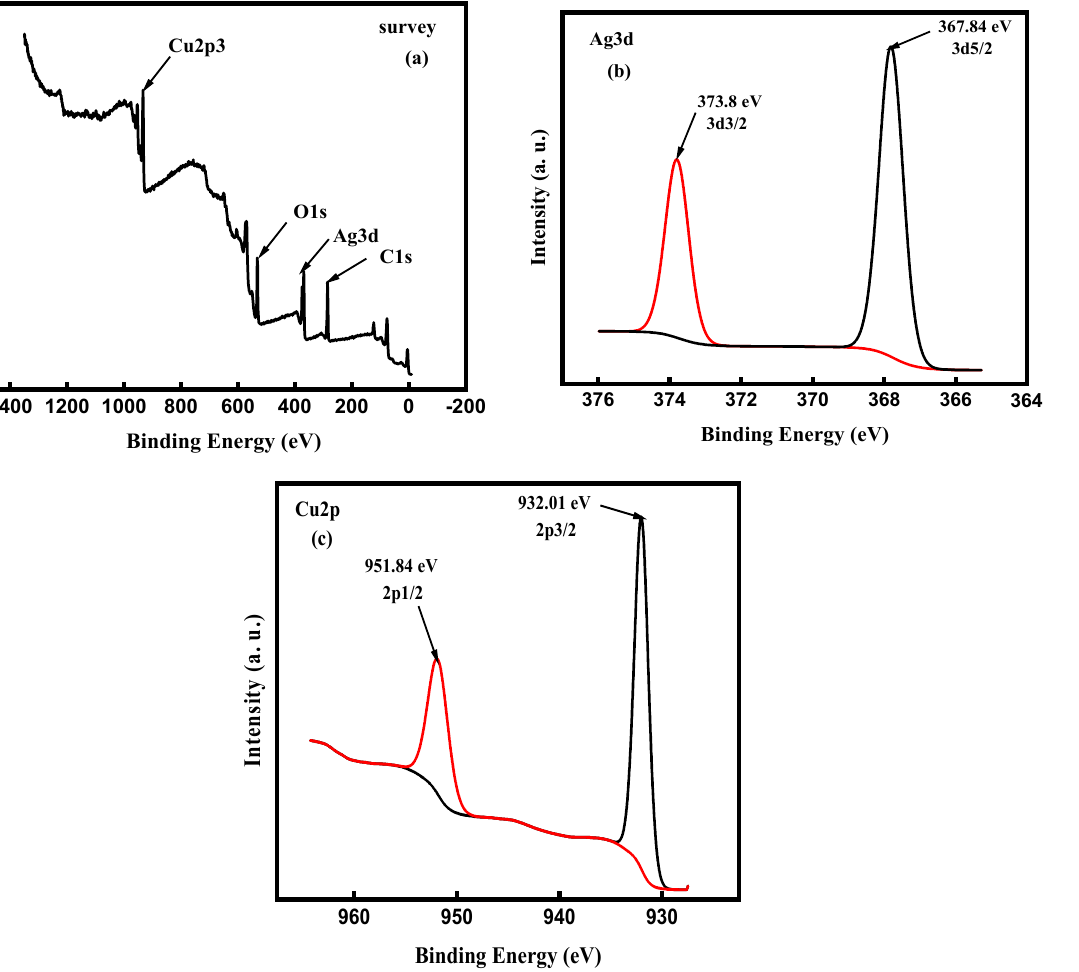
Figure 12. XPS results of the as-synthesized ncCuAg ( a ) Survey spectra, ( b ) Ag3d spectra, and ( c ) Cu 2p spectra.